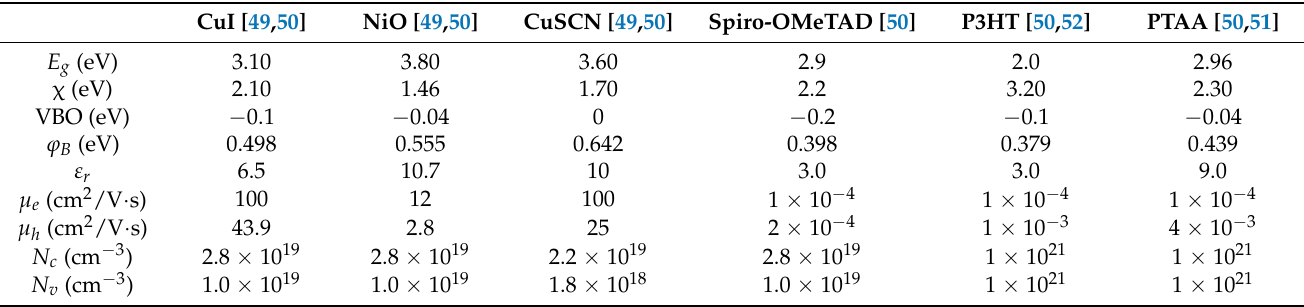
Table 4. Main input physical parameters of various HTL